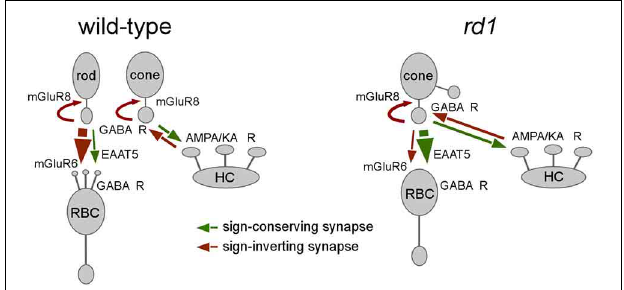
FIGURE 8 | Functional remodeling in the outer rd1 retina. Drawings illustrating the differences in synaptic interactions between wild-type (left) and the synaptically remodeled rd1 (right) outer retina. For simplicity, interactions between HCs and rods/RBCs in wild-type and gap junctions are not shown (sign-conserving synapses, green arrows; sign-inverting synapses, red arrows; EAAT5, excitatory amino acid transporter 5, mGluR; metabotropic glutamate receptors; GABA R, GABA receptors; AMPA/KA R, AMPA/kainate-type glutamate receptors).